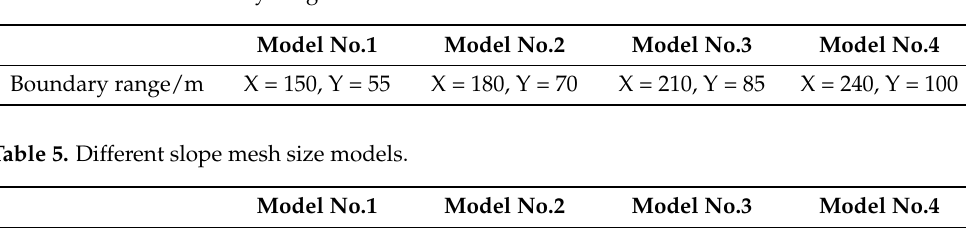
Table 4. Different boundary range models.